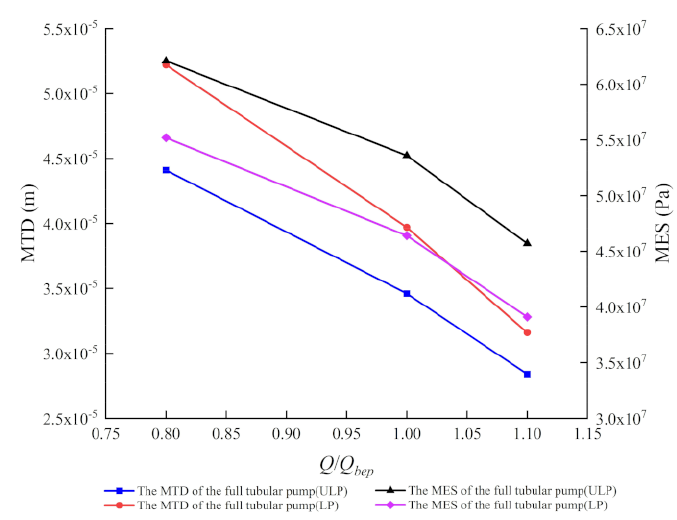
Figure 15. Comparison of MTD and MES between ULP and